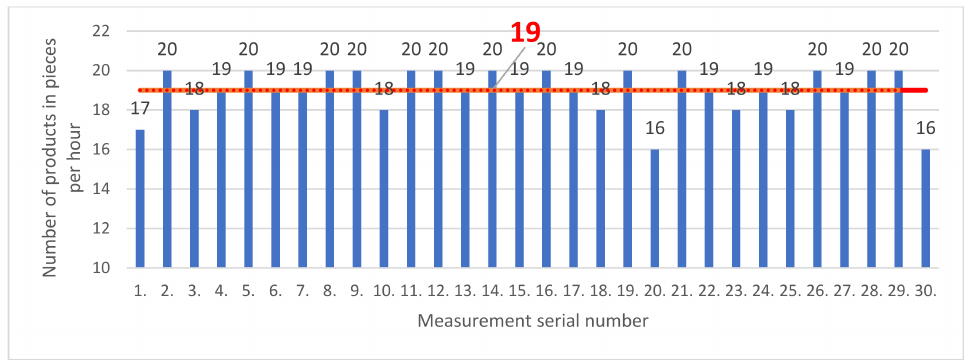
Figure 4. Average initial hourly output of the production